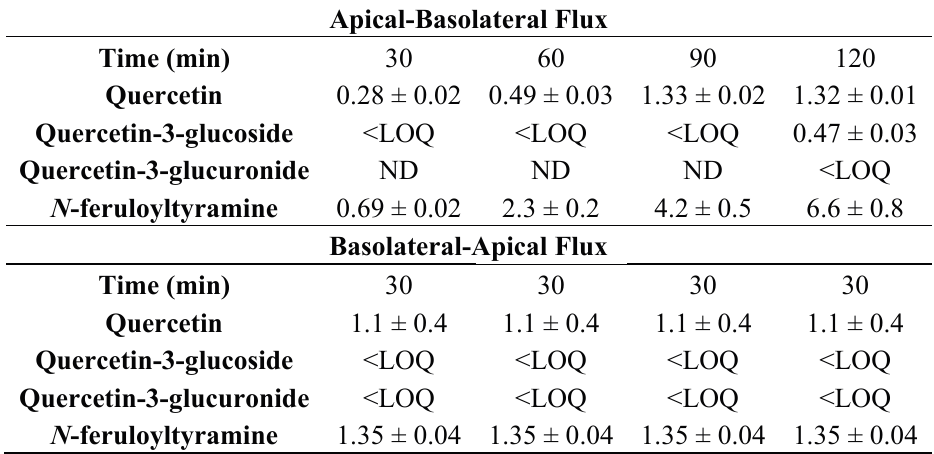
Table 4. Concentration ( μ g/mL) of compounds from the receptor chamber in the individual permeability assays. Value = X ± SD. ND: non-detected, <LOQ: below the